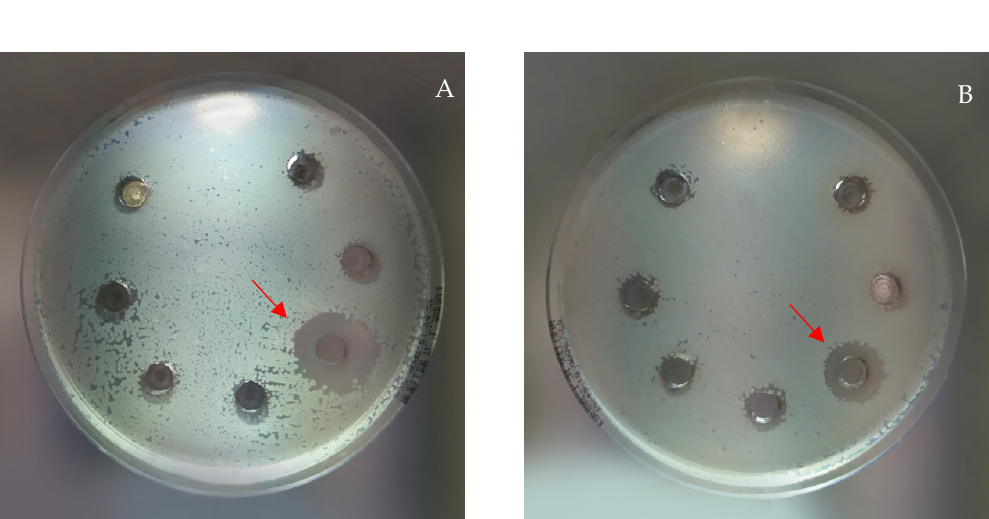
Figure 3. Inhibition halos measured for extract K (red arrow) at the concentrations of 5 mg/mL, 15 mm ( A ), and 2.5 mg/mL, 13 mm ( B ).